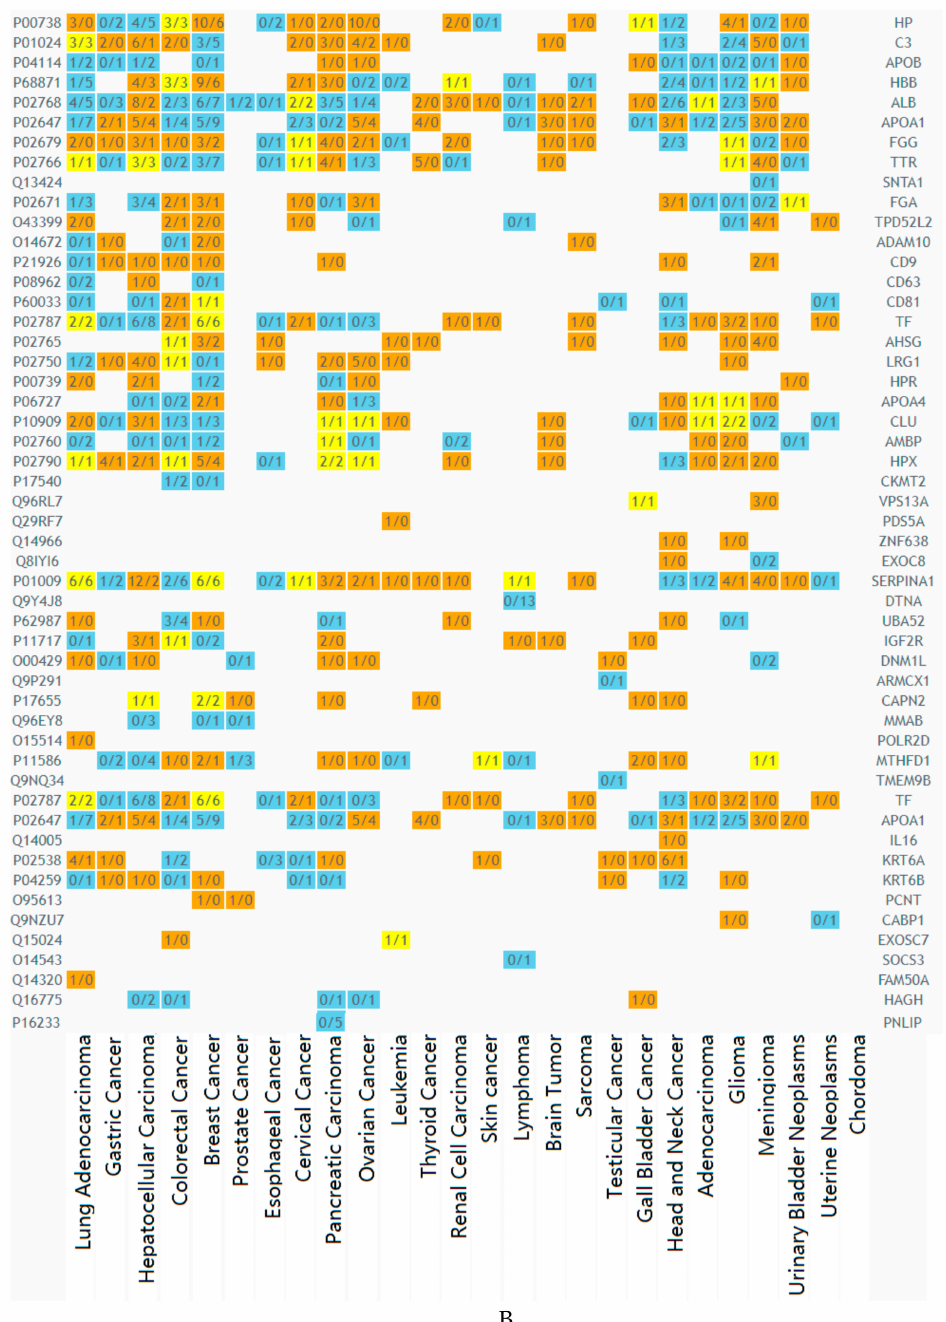
Figure 4. Heat map generated by dbDEPC 3.0 [17] from exosomal proteins from BCP blood, associated with di ff erent cancer types; plasma exosomes ( A ), total blood exosomes ( B ). Orange means that the number of the studies identified this protein as up-regulated is more than the number of the studies identified the protein as down-regulated; blue means that the number of the studies identified this protein as up-regulated is less than the number of the studies identified protein as down-regulated; yellow means that the number of the studies identified the protein as up-regulated is equal to the number of the studies identified protein as